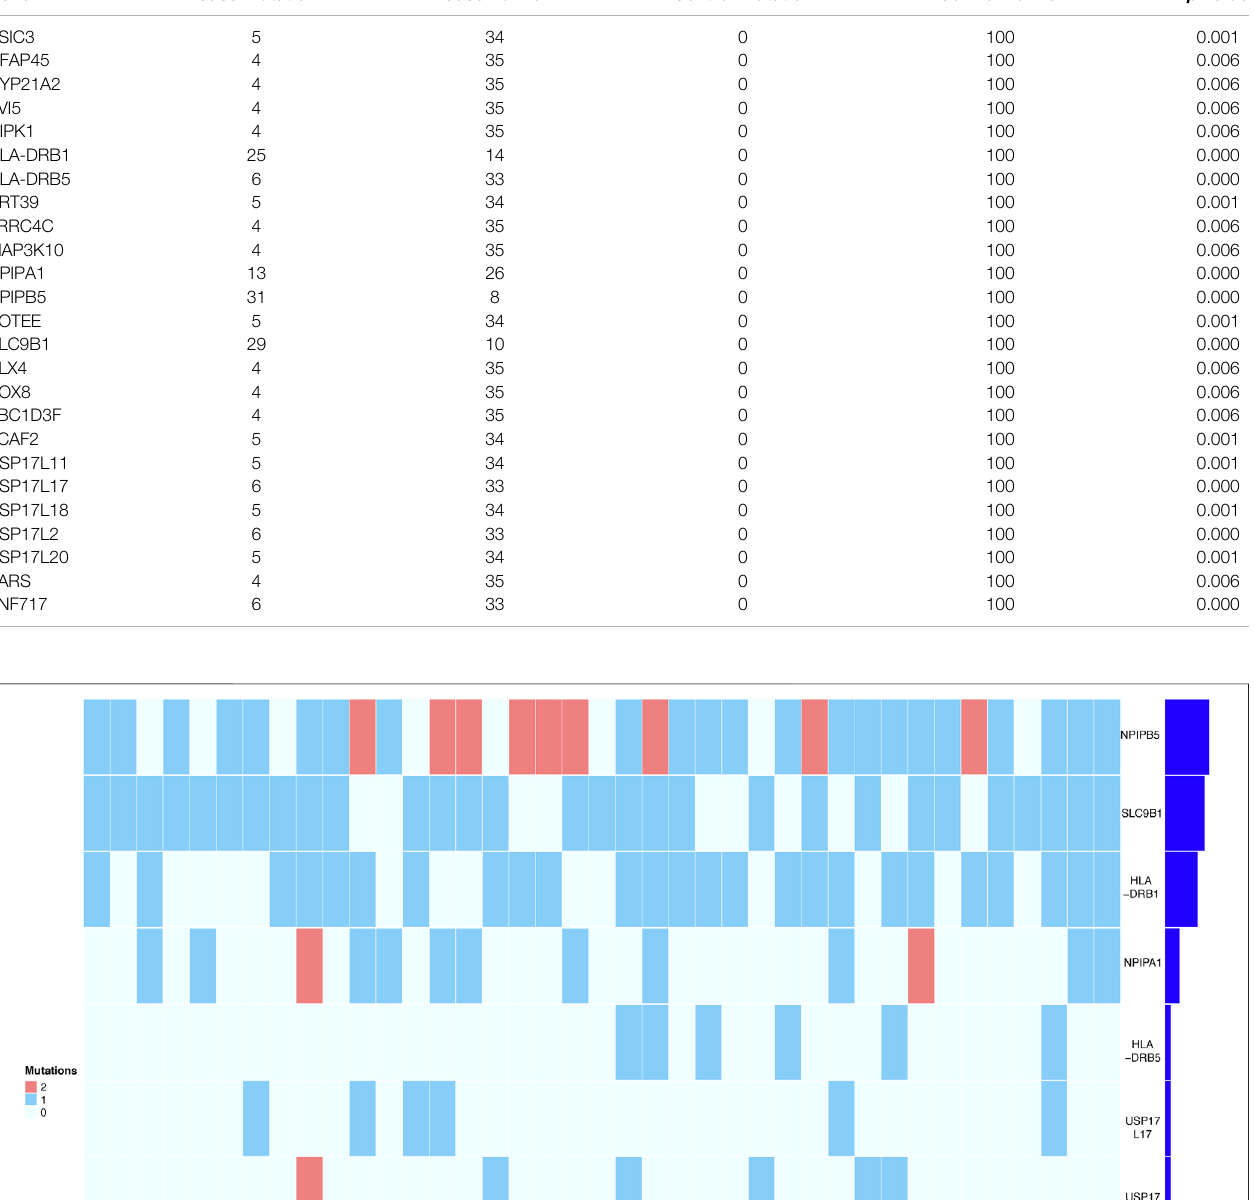
Frontiers in Genetics |